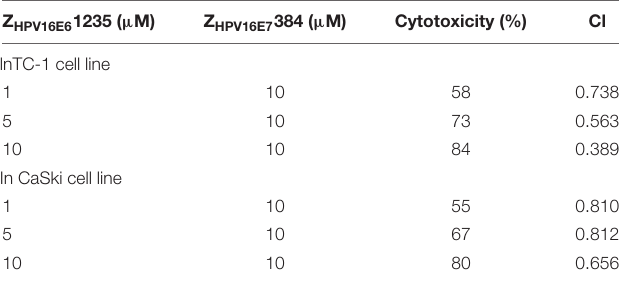
TABLE 2 | The synergistic therapeutic effect of Z HPV 16 E 61235 in combination with Z HPV 16 E 7384 was demonstrated by Chou-Talalay analysis. Z HPV16E6 1235 ( µ M) Z HPV16E7 384 ( µ M) Cytotoxicity